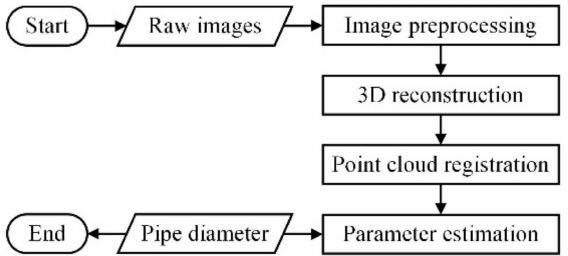
Figure 2. Flow chart of measurement